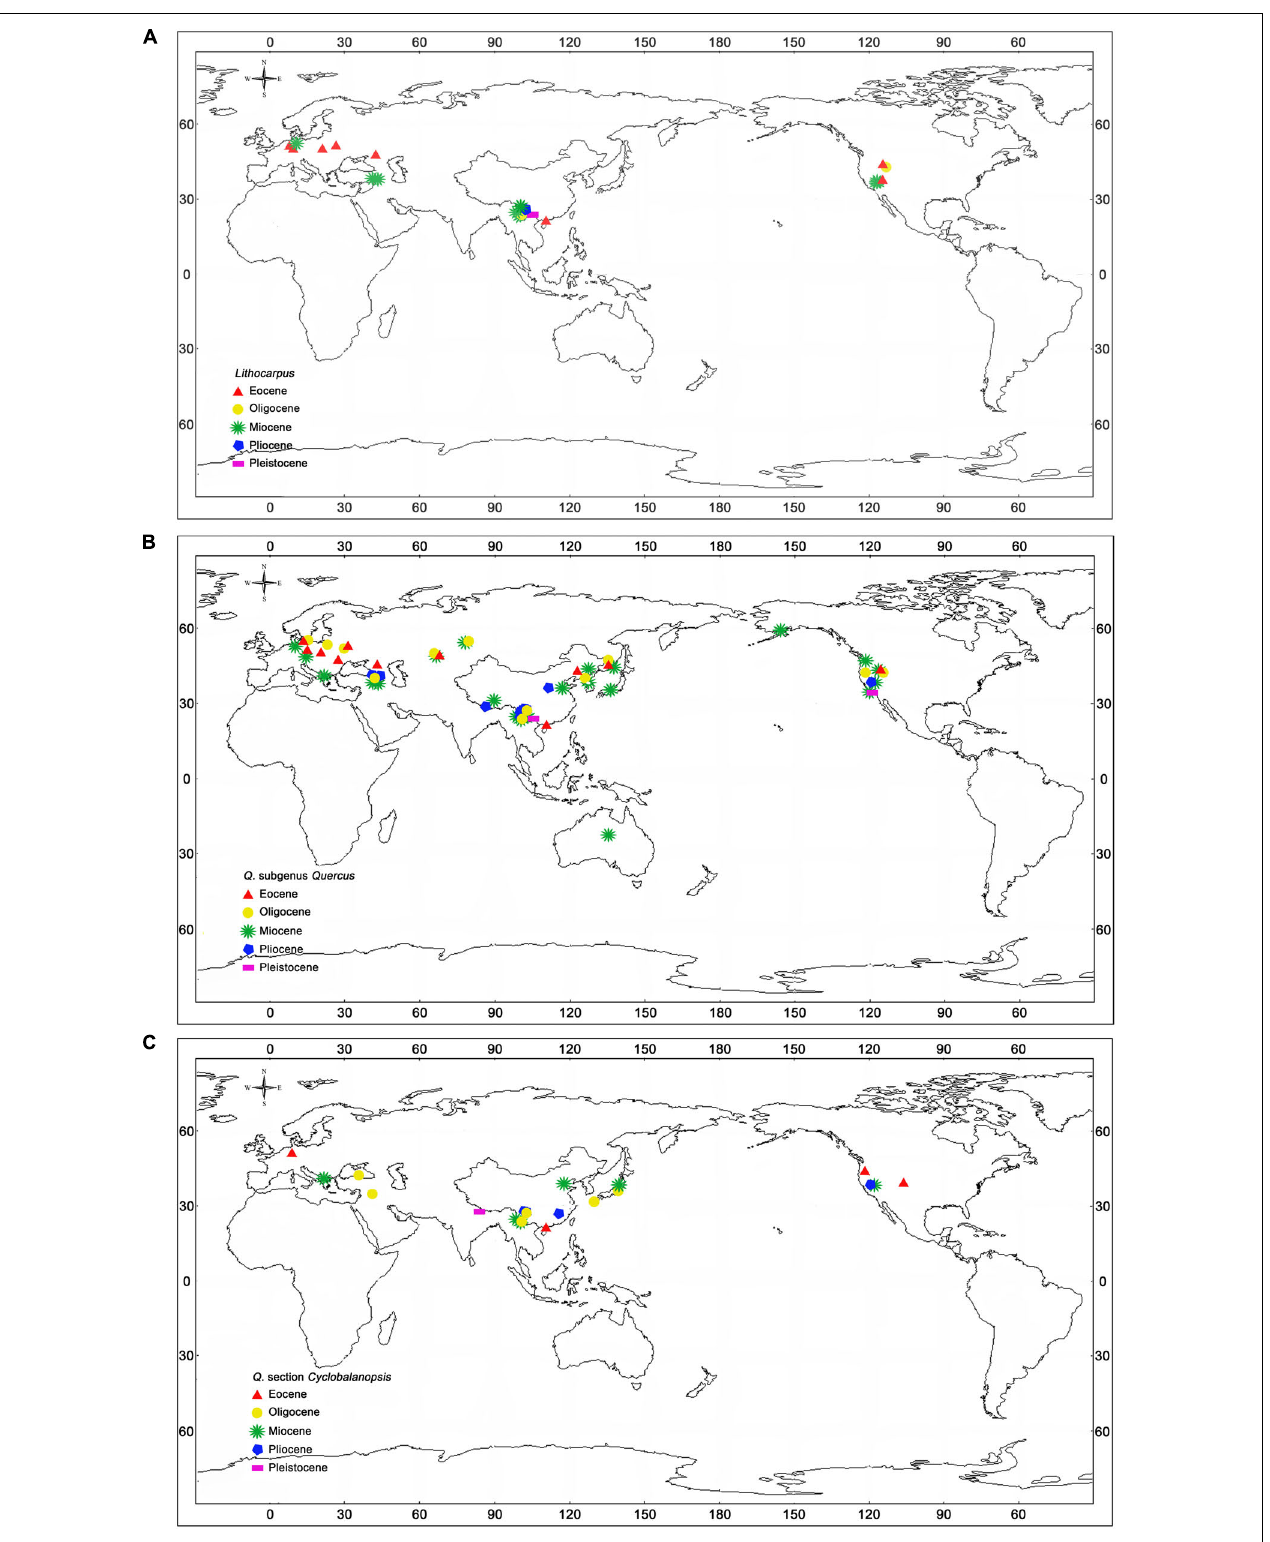
FIGURE 15 | Distribution of the fossil records for the Lithocarpus , Quercus subgenus Quercus and Q . section Cyclobalanopsis . (A) Distribution of the fossil records of Lithocarpus ; (B) distribution of the fossil records of Q . subgenus Quercus ; (C) distribution of the fossil records of Q . section Cyclobalanopsis .